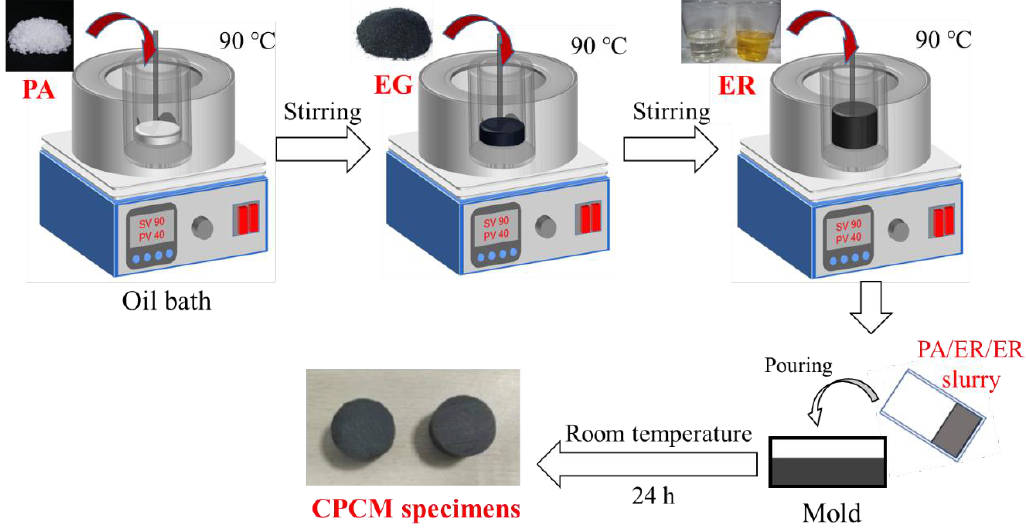
Figure 1. The preparation process of the CPCMs via the physical-blending method. A thermal conductivity analyzer (LFA447, NETZSCH-Gerätebau GmbH, Selbu, Ger- many) and a differential scanning calorimeter (DSC, METTLER TOLEDO DSC3, Zurich, Switzerland) were utilized to test the thermal conductivity, latent heat and phase change temperature of the CPCM. The mechanical strength of PA and CPCM was measured with a Hounsfield universal testing machine.